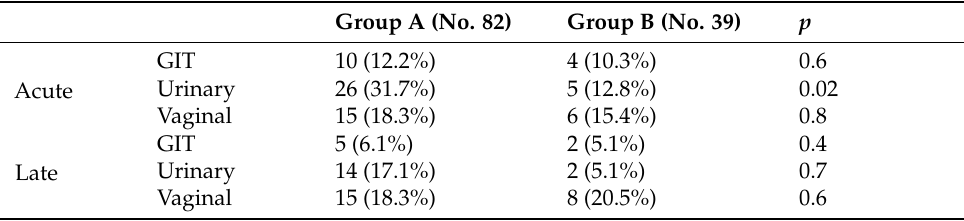
Table 4. Acute and late radiation toxicity between treatment